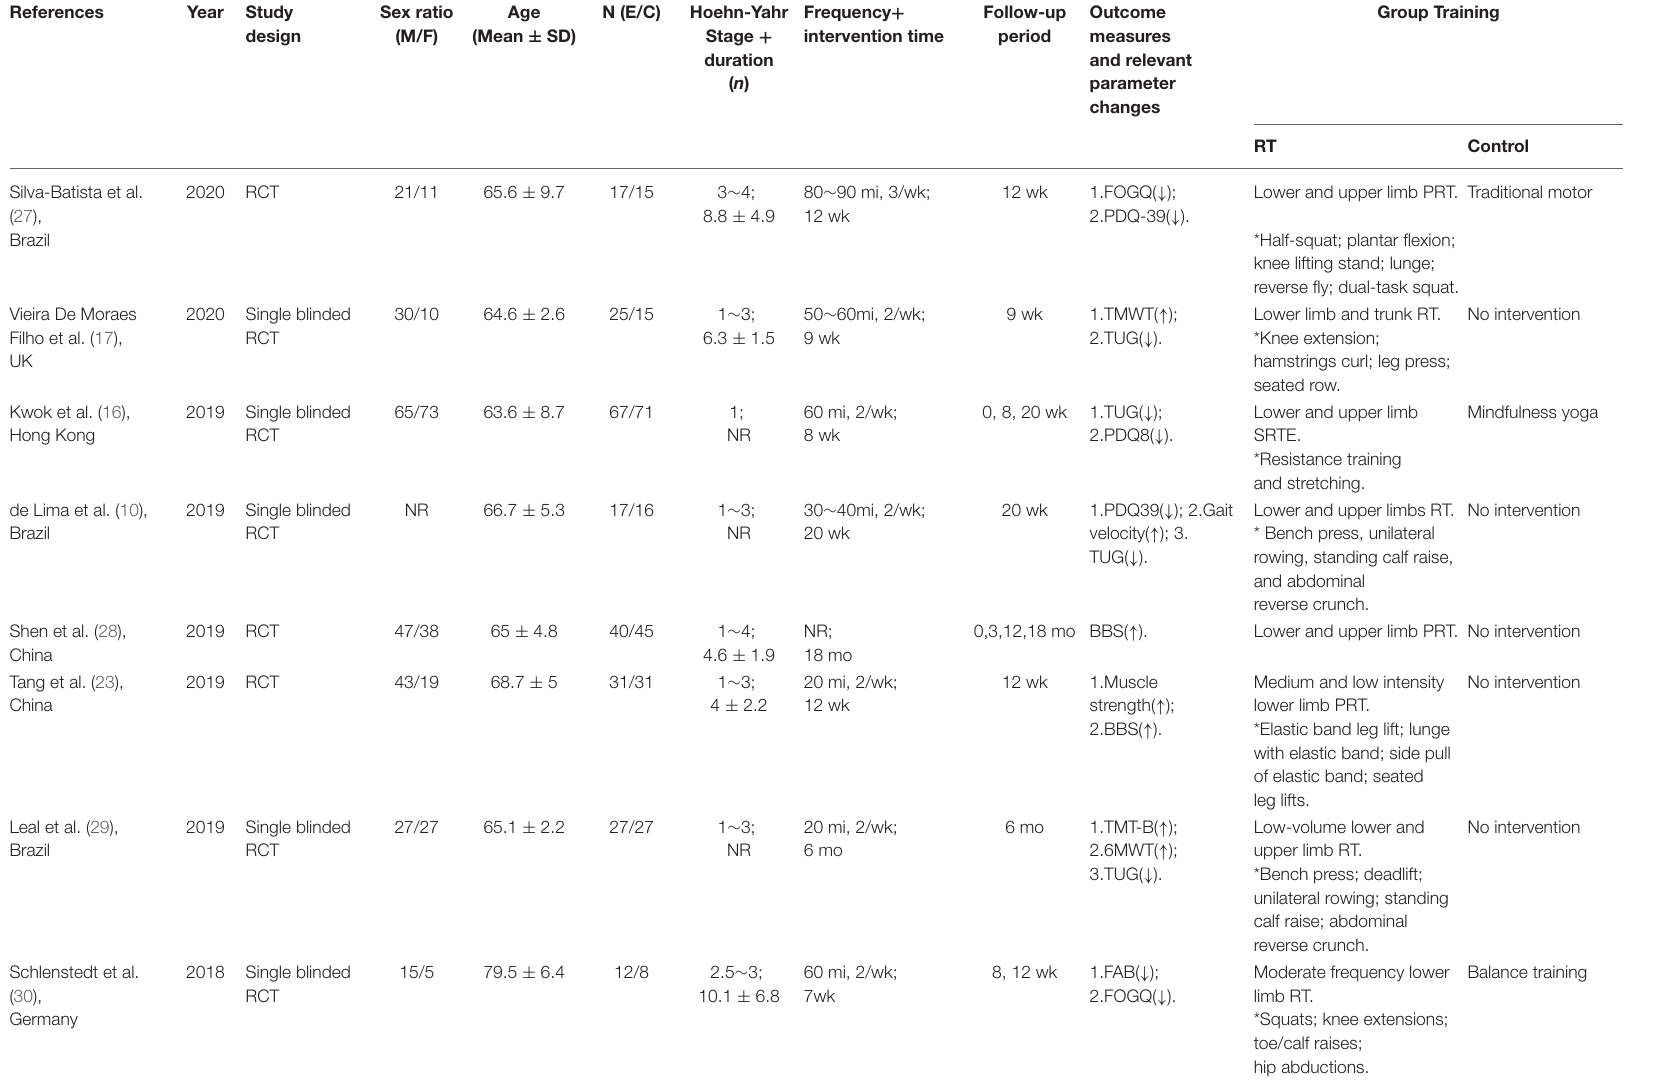
TABLE 1 | General characteristics of these included articles concerning the effects of lower limb RT in individuals with